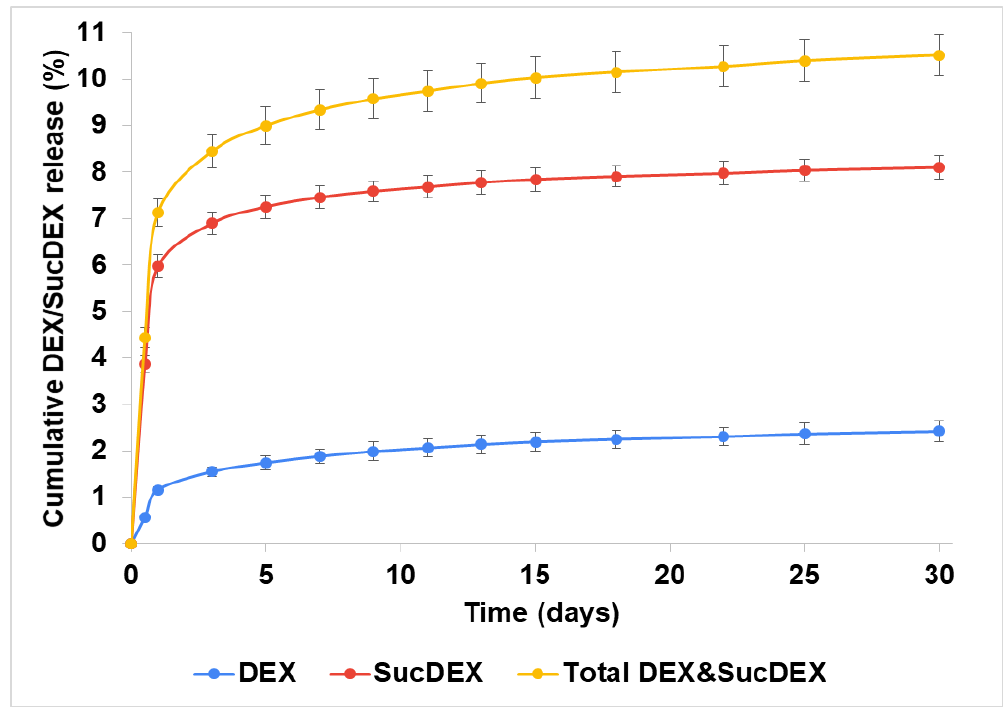
Figure 5. Release of DEX and SucDEX from the SucCS-DEX-10 particles; n = 3, error bars represent one standard deviation.